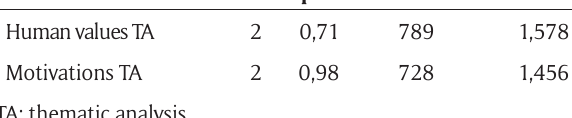
Table 5: Krippendorff’s alpha